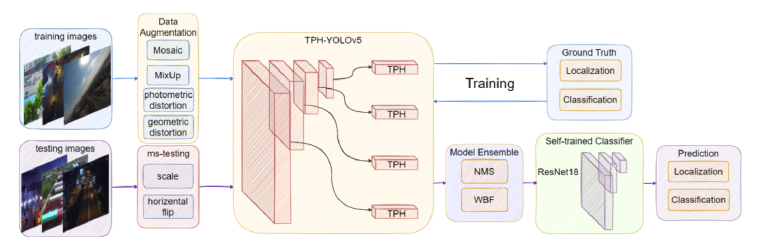
Figure 10. Architecture of